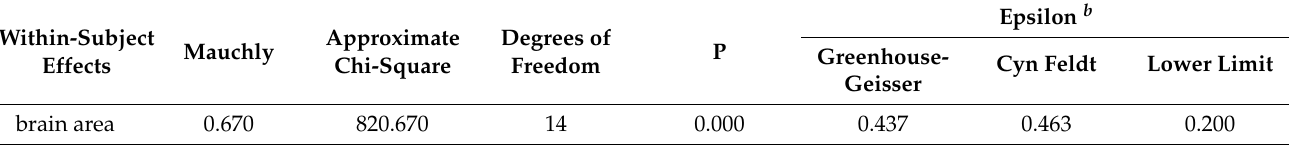
Table 10. Mauchly sphericity test.